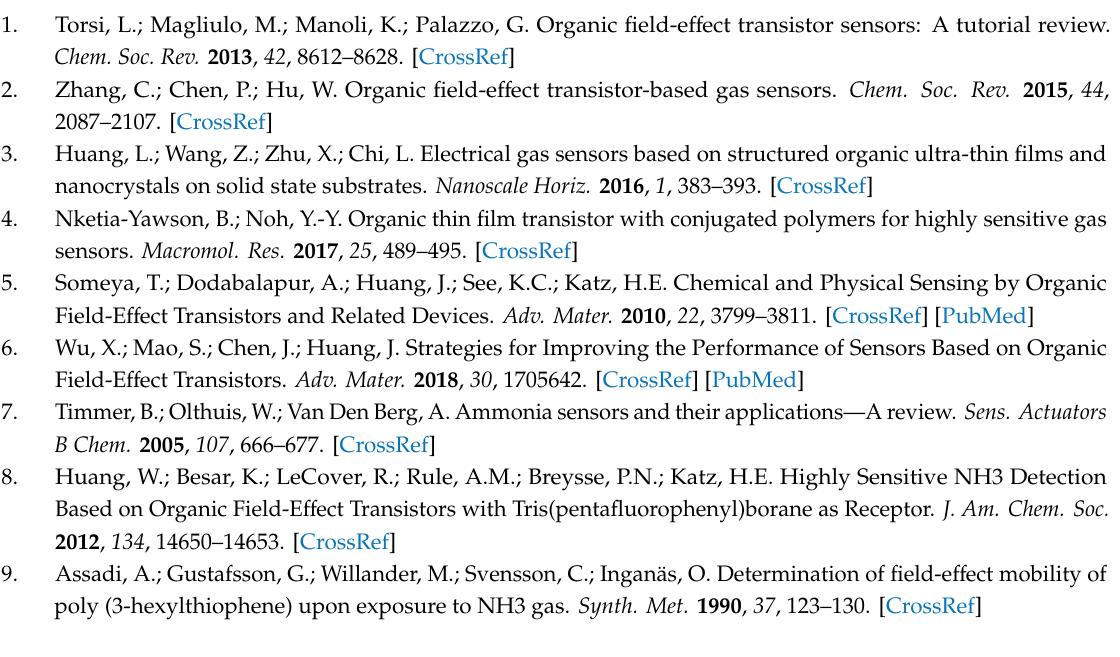
Figure S1: Selectivity of sensors made from thin polymer films: (a) P3HT and (b) P3HT:TPFB = 9:1. The current was recorded at the gate voltage of 0 V. The film thickness was controlled to be ~31 nm, Figure S2: Percentage current responses of the P3HT:TPFB (9:1) devices for individual analyte at 10 ppm and the mixture of four analytes (10 ppm each). The current was recorded at the gate voltage of − 100 V, Figure S3: Real-time responses of a P3HT:TPFB (9:1) device during multi-cycling of sequential exposure to NH 3 (10 ppm) and N 2 -gas flush. The current was recorded at the drain and gate voltages of − 100 V, Figure S4: Transfer curves of a P3HT:TPFB (9:1) device before NH 3 exposure, during NH 3 exposure, and after recovery in N 2 environment, Figure S5: (a) Transfer curves of a P3HT:TPFB (9:1) device in water vapor. (b) Percentage current responses of a P3HT:TPFB (9:1) device to a various concentration of H 2 O vapor. The current was recorded at the gate voltage of − 100